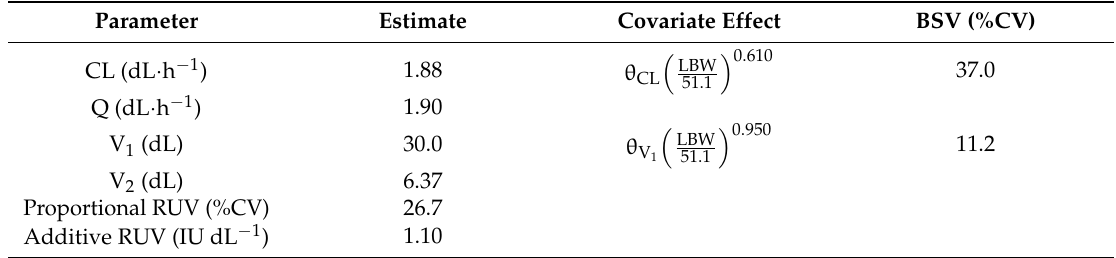
Table 1. Details of the model developed by Garmann et al. [31]. CL: clearance; Q: intercompartmental clearance; V 1 : volume of the central compartment; V 2 : volume of the peripheral compartment; RUV: residual unexplained variability; BSV: between subject variability; LBW: lean body